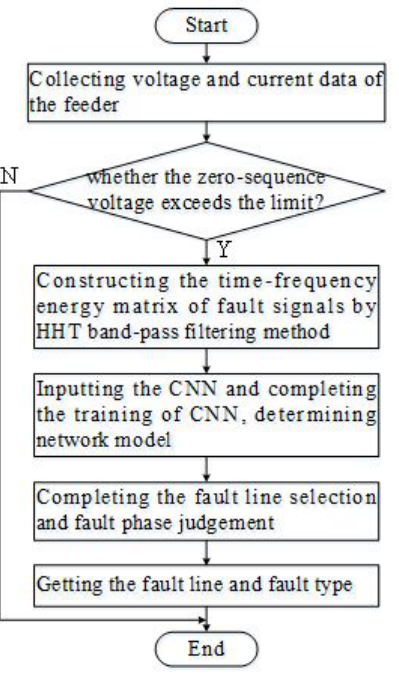
Fig. 6. Principle diagram of fault line selection based on CNN